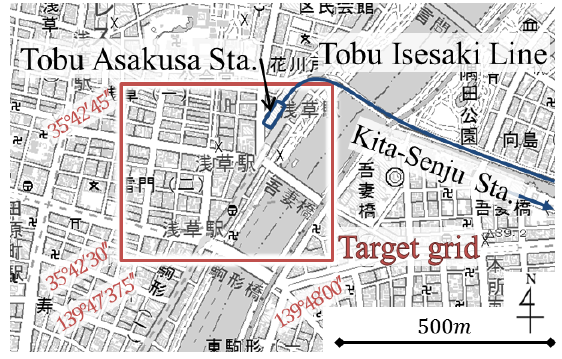
Figure 6: Location of the target grid